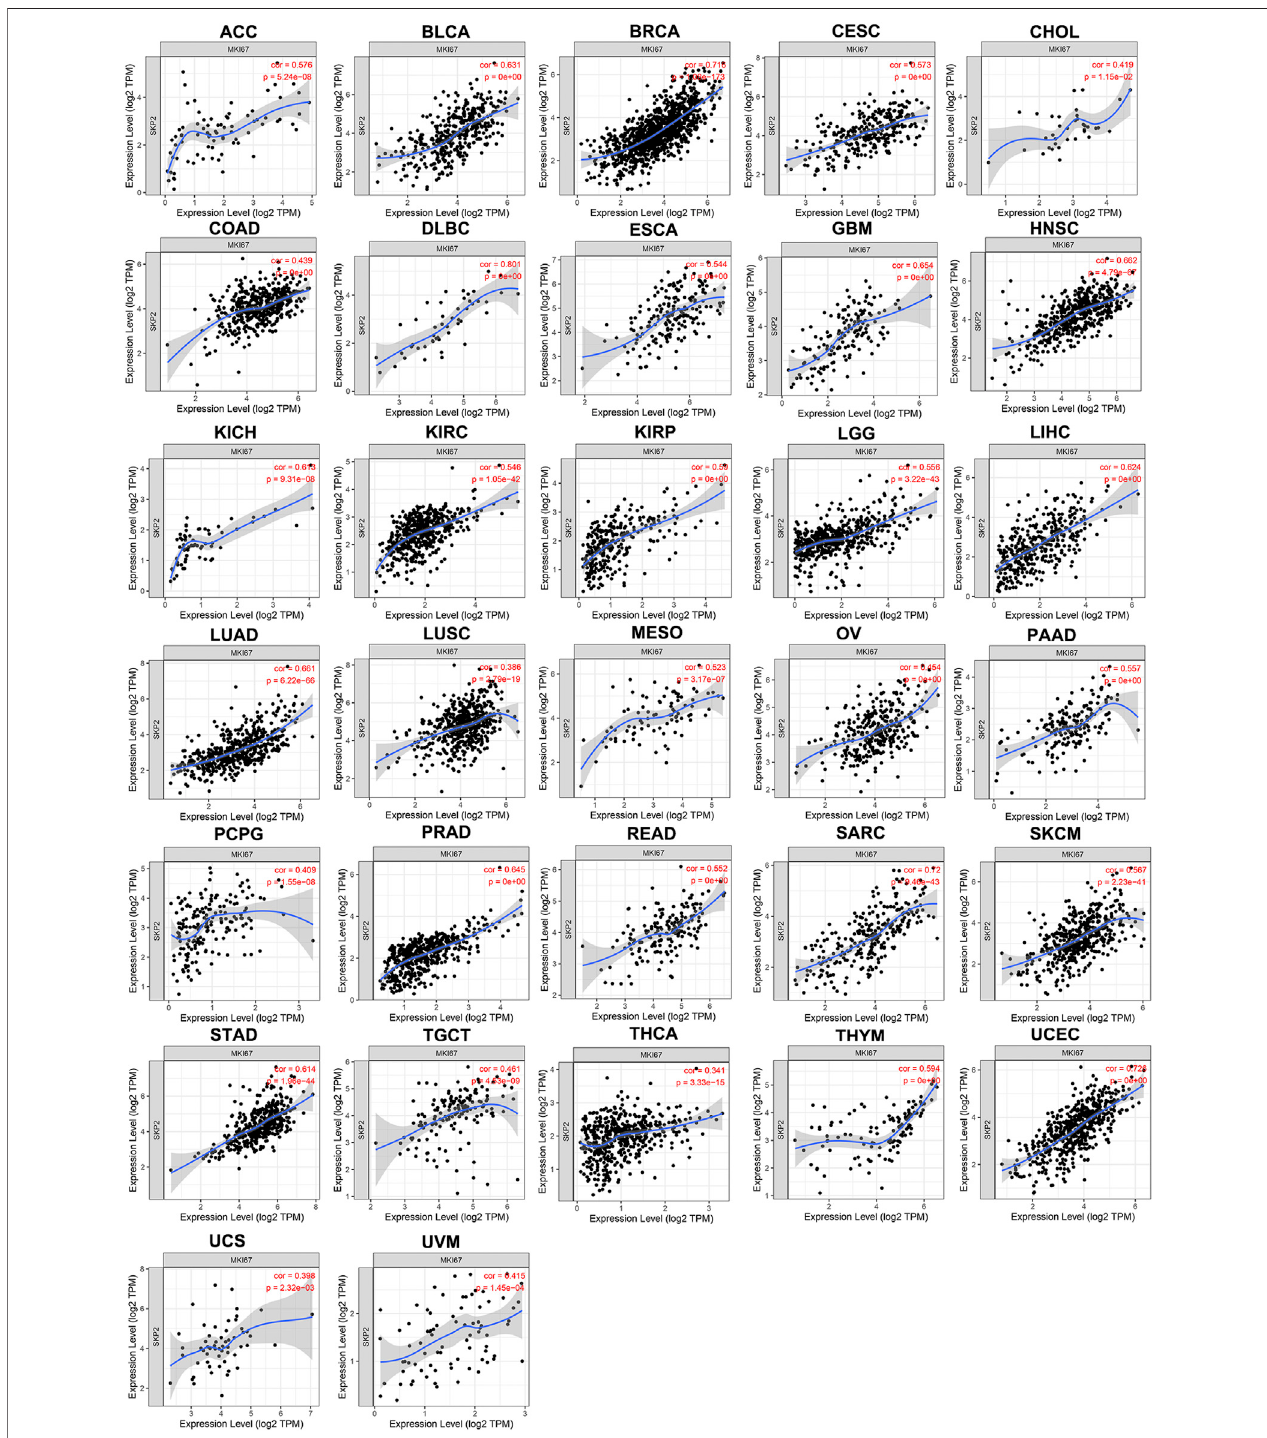
FIGURE 8 | The positive correlation between SKP2 and MKI67 expression analyzed by TIMER in pan-cancer.